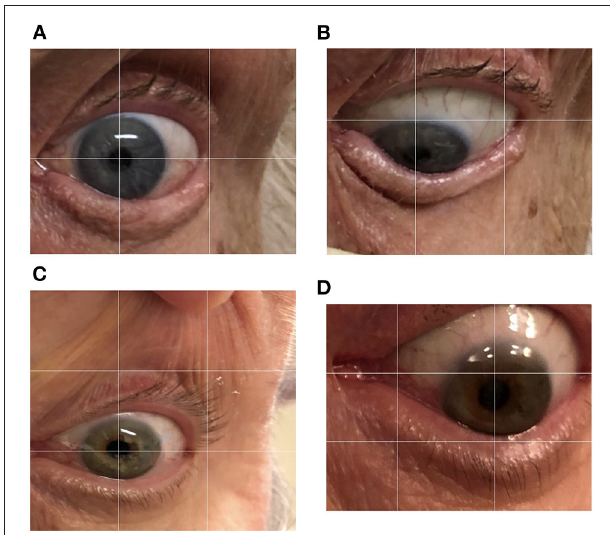
FIGURE 2 | Quantification of downgaze palsy in practice. We can simply take a picture of the eyes using a common smart phone, and use the crop function to enlarge/rotate (if needed) the eye and superimpose a grid on it in the context of the intercanthal line, center of the pupil, and upper edge of the iris. To demonstrate the concept and bedside practice of this method, here we collected pictures showing a healthy eye in neutral position with a grid (A) , and in maximal downgaze with a grid (B) , an abnormal eye of a PSP patient’s with 100% limited downgaze palsy with a grid (C) , and an abnormal eye of a PSP patient’s with 70% limited downgaze palsy with a grid (D)